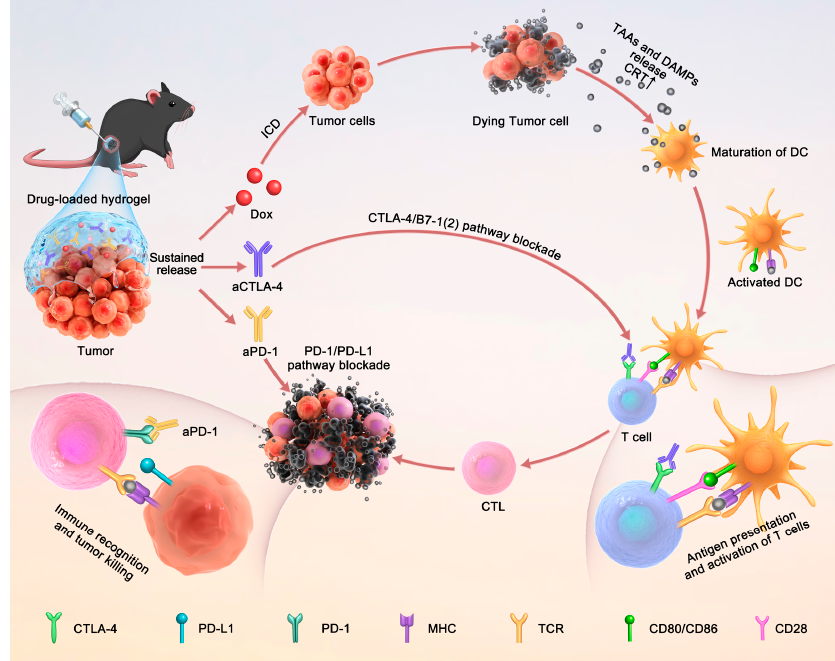
Scheme 1. Schematic illustration of sustained co-delivery of Dox, aCTLA-4 and aPD-1 by an injectable hydrogel for antitumor chemo-immunotherapy. After peritumoral injection of the multiple agent co-loaded hydrogel into tumor-bearing mice, the Dox release can induce ICD of tumor cells to release DAMPs and TAAs, promoting the maturation of dendritic cells (DCs). The subsequent antigen presentation by DCs to T cells can be enhanced by inhibiting the binding between CTLA-4 and CD80/86, with aCTLA-4. Additionally, the continuous release of aPD-1 can block the PD-1/PD-L1 pathway, thereby inhibiting the immune escape of tumor cells.